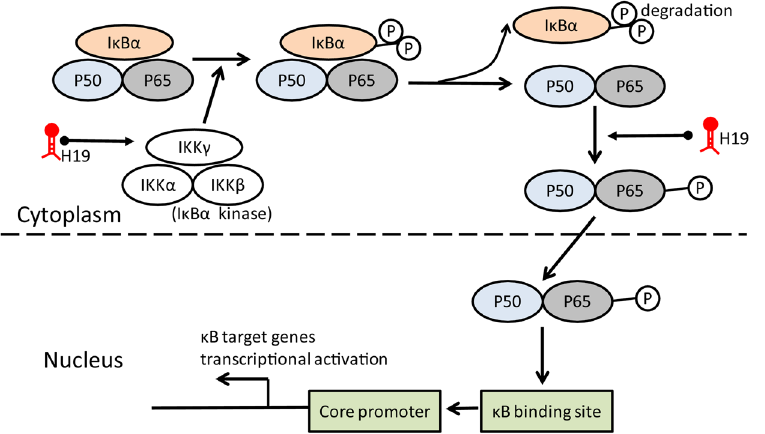
Figure 7. A schematic representation of the proposed model: possible mechanism of H19 via the NF- κ B pathway regulated growth of MM. H19 induced phosphorylation of the typical I κ B α , marking it for degradation, thus led to an enhanced nuclear NF- κ B accumulation. Otherwise, H19 could directly promote P65 phosphorylation. Subsequently, nuclear P65 might bind to IL-6 and IL-8 promoter regions, and promoted their